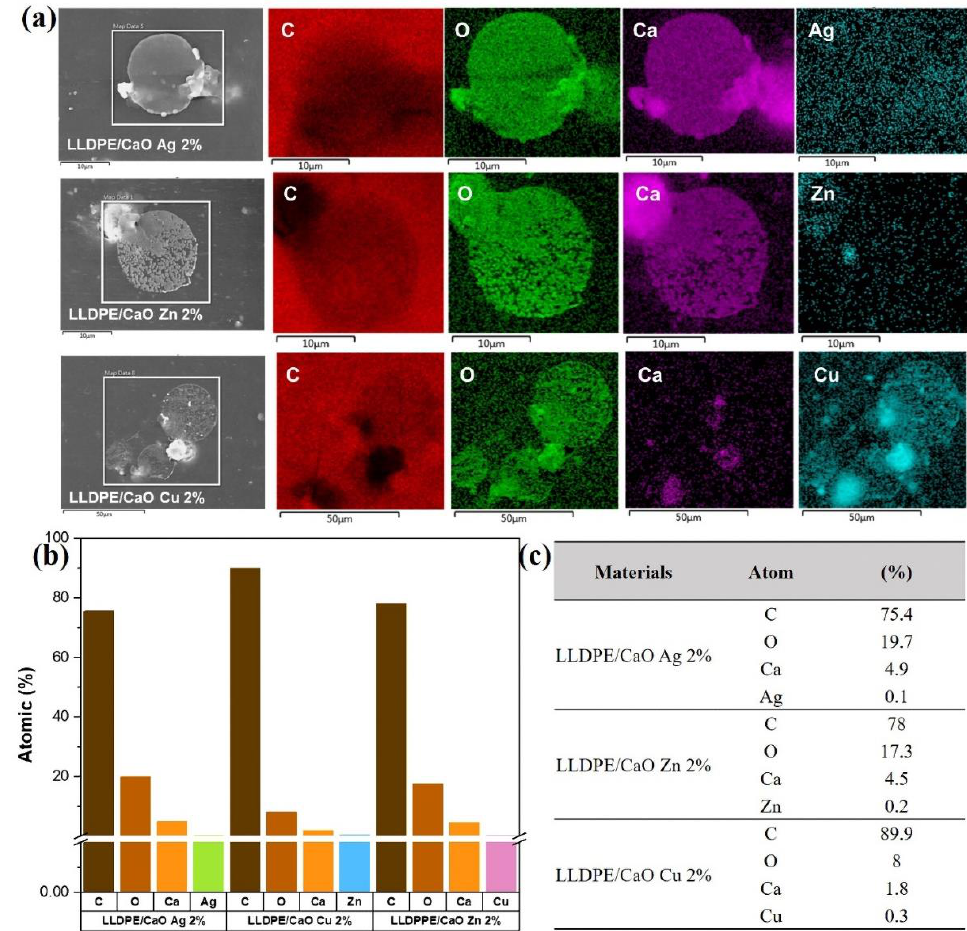
Figure 4. ( a ) Energy-dispersive X-ray spectroscopy (EDX) mapping of a small area of LLDPE/CaO Ag 2%, LLDPE/CaO Zn 2%, and LLDPE/CaO Cu 2%. ( b ) the atomic percentage of LLDPE/CaO Ag 2%, LLDPE/CaO Zn 2%, and LLDPE/CaO Cu 2%. ( c ) atomic percentage data from EDX measurement.